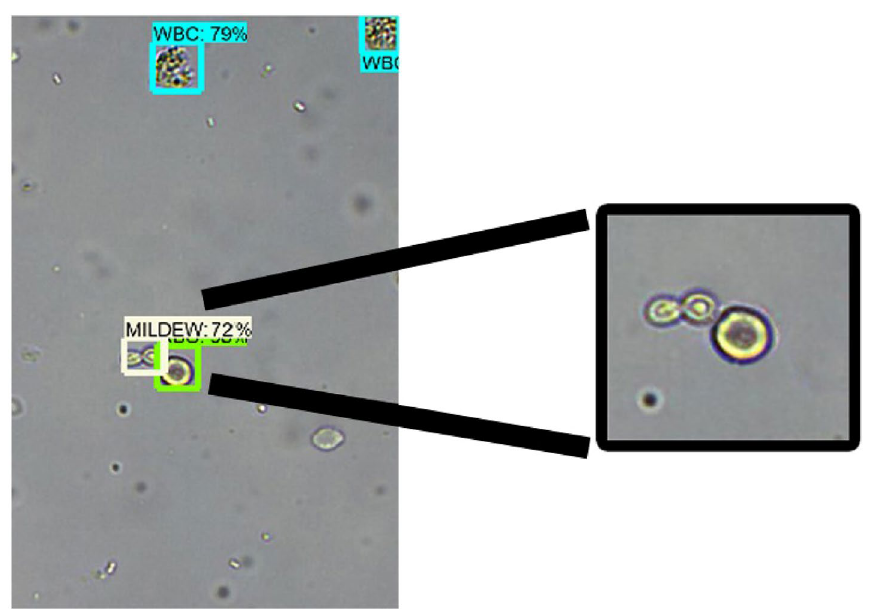
Figure 6. Detection result for adhesion